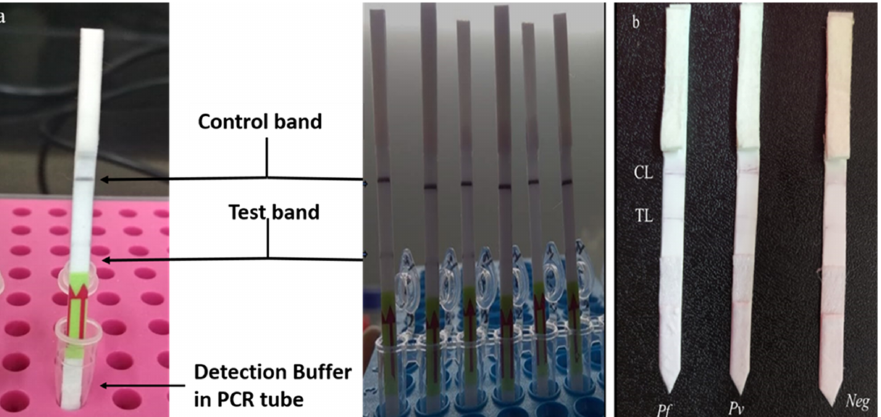
Figure 6. ( a , b ) : PCRbeam™ fast polymerase chain reaction (PCR) detection dipstick in PCR tube with detection buffer showing control band and test band. 2. P. vivax ( n = 2), control sample ( n = 2), and no template ( n = 2) on 6 strips from left to right. When there was no PCR product in the reaction, then only the control band was visible. When the target specific product was present, the test band was visible. Similarly, we found the results for P. falciparum and P. vivax on the assembled lateral flow strips as shown in ( b ). CL— Control line and TL—Test line.